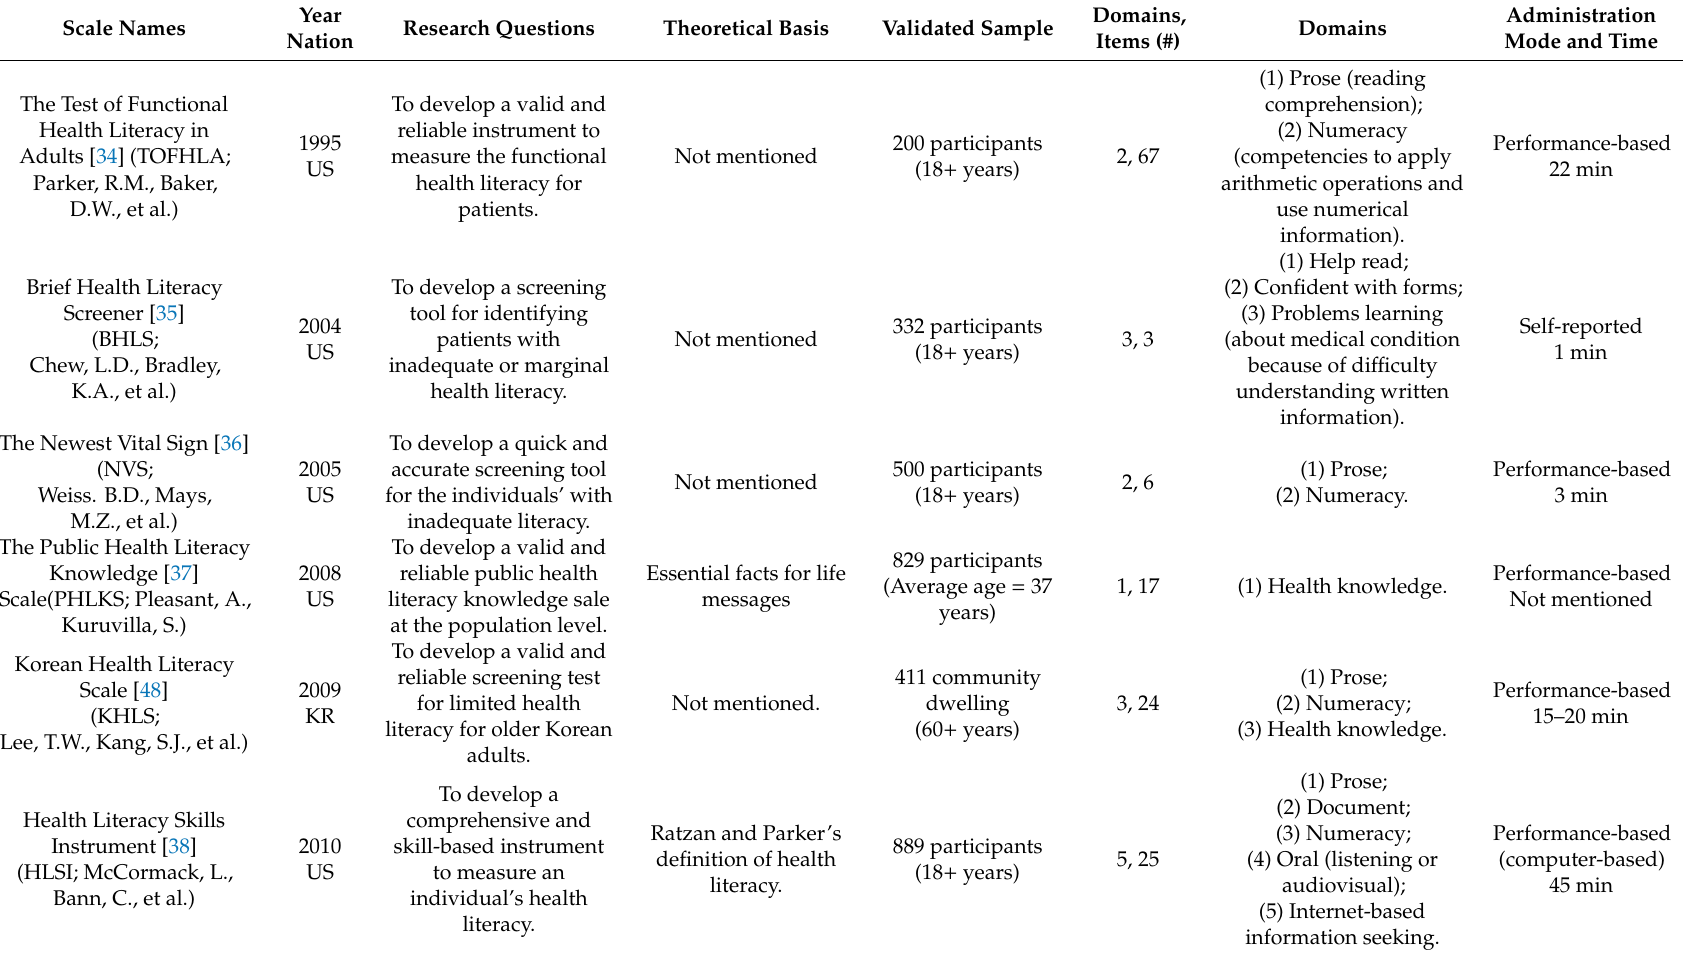
Table 1. Instrument characteristics of tools assessing generic health literacy among